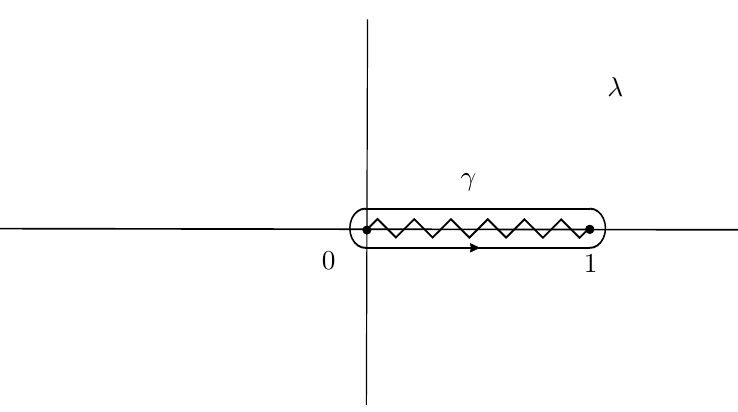
Figure 1 . Contour used in (2.20). The resolvent ( λ − G ) − 1 must possess a cut along [0 , 1] , the spectrum of G